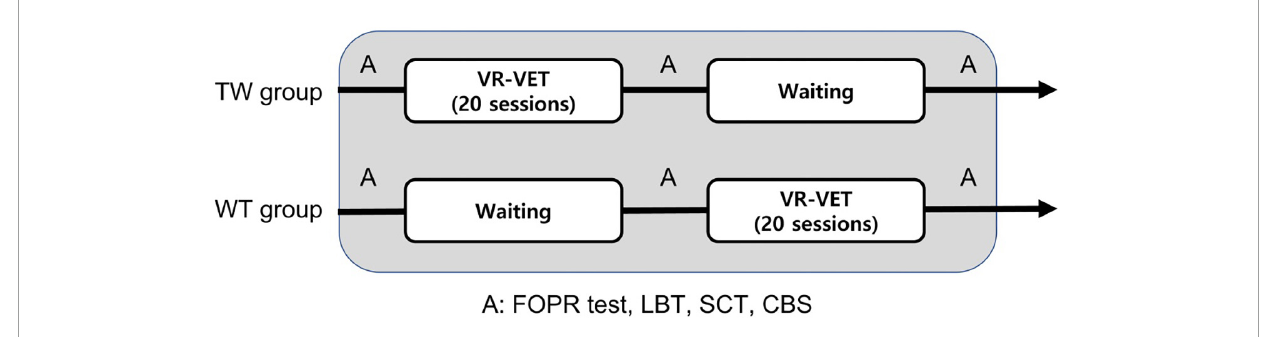
FIGURE1 Schematic representation of the rehabilitation program. A, assessment; CBS, Catherine Bergego Scale; LBT, line bisection test; SCT, star cancellation test; TW, training first followed by waiting; WT, waiting first then training; VR-VET, virtual reality-based visual exploration therapy.